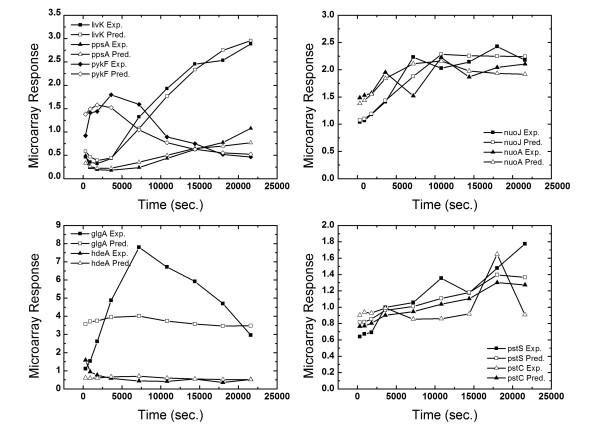
Comparison of predicted (hollow markers) and observed (solid markers) microarray response for a) nuoJ, nuoA, b) arcA, c) livK, ppsA, pykF, d) pstC and pstS.